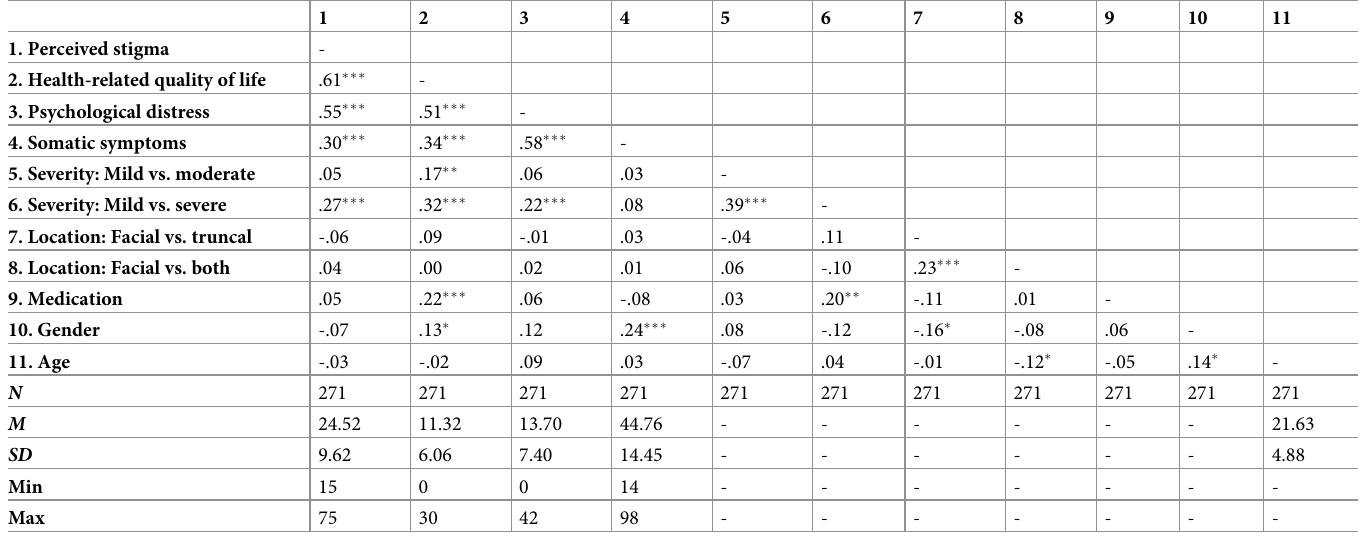
Table 1. Intercorrelates and descriptive